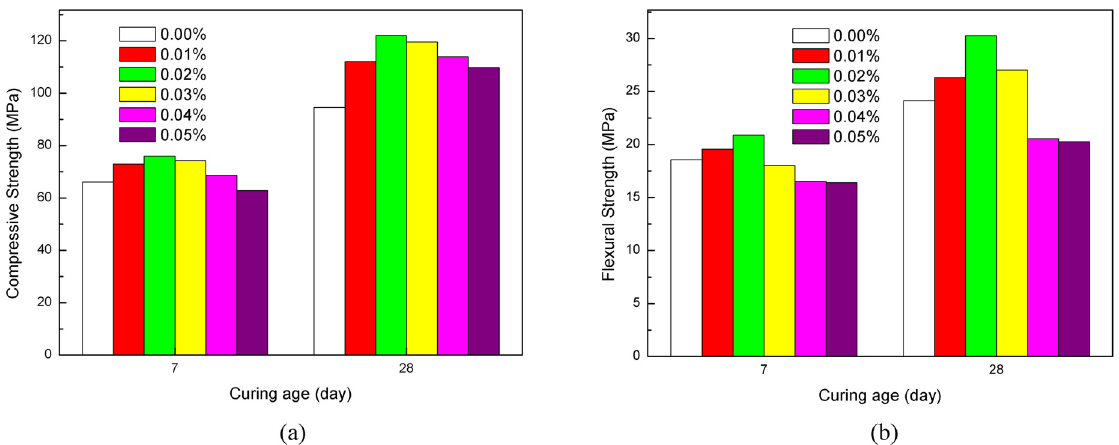
Figure 7: E ff ect of di ff erent content of GO application on UHPC: ( a ) compressive strength and ( b ) fl exural strength [ 83 ] .